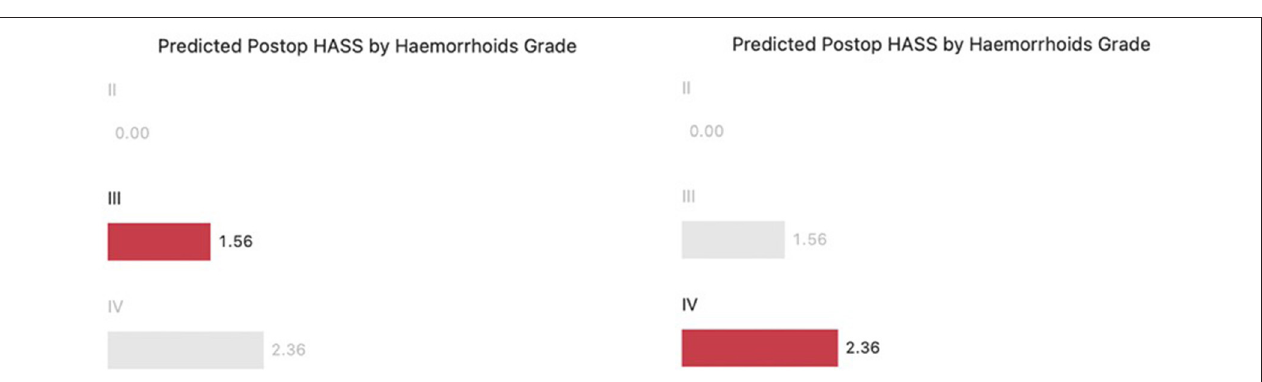
Frontiers in Surgery |